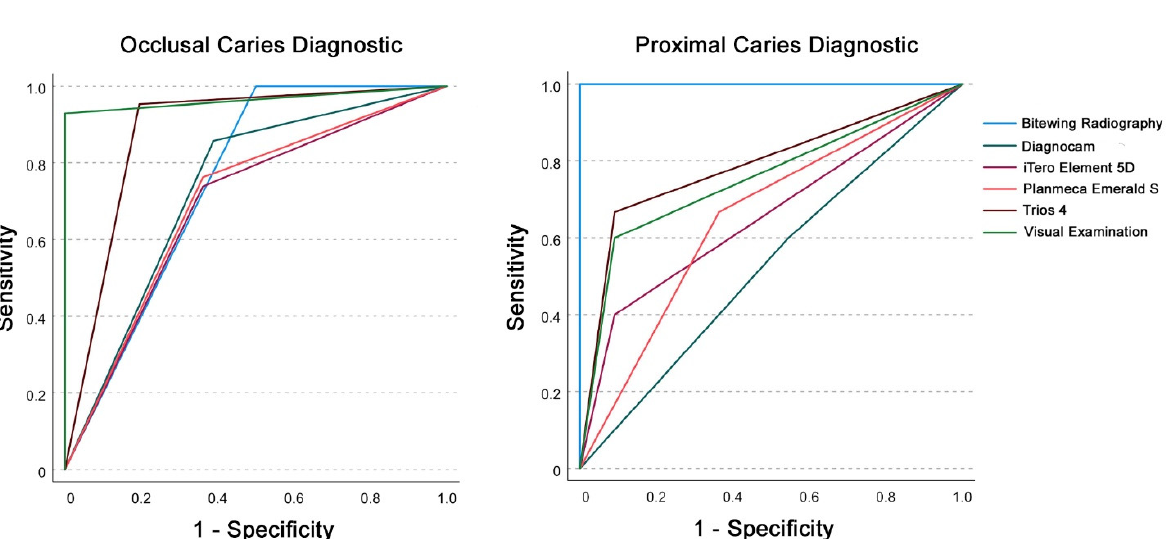
Table 2. Caries diagnostic methods regarding sensitivity, specificity, and area under curve (AUC) values with receiver operating characteristic (ROC) curve analysis for threshold II (sound/enamel caries versus dentin caries).